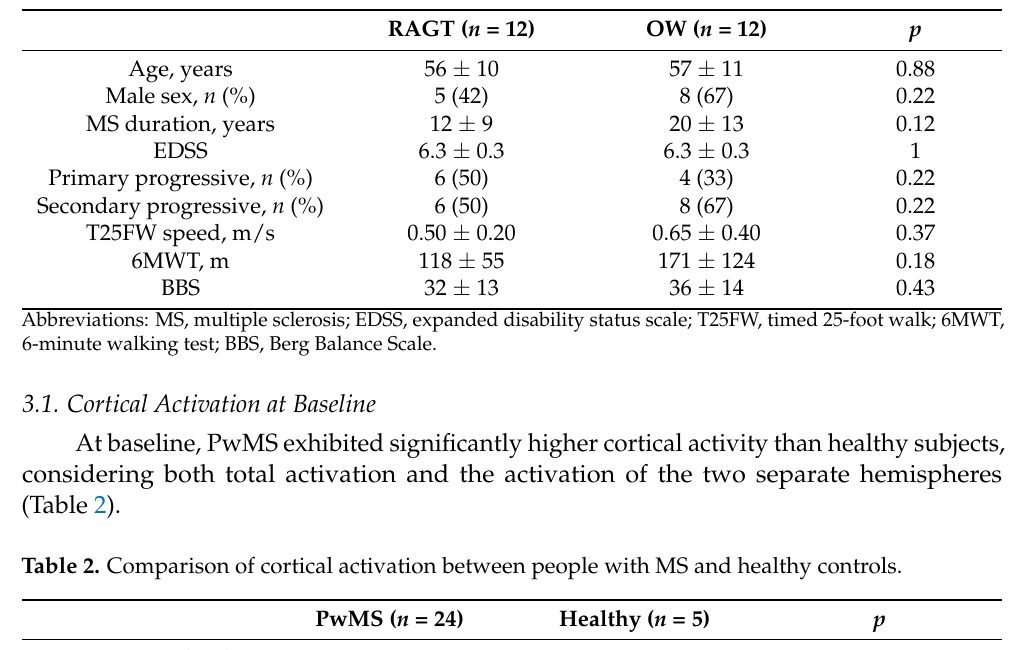
Table 1. Patients’ characteristics at the entry.